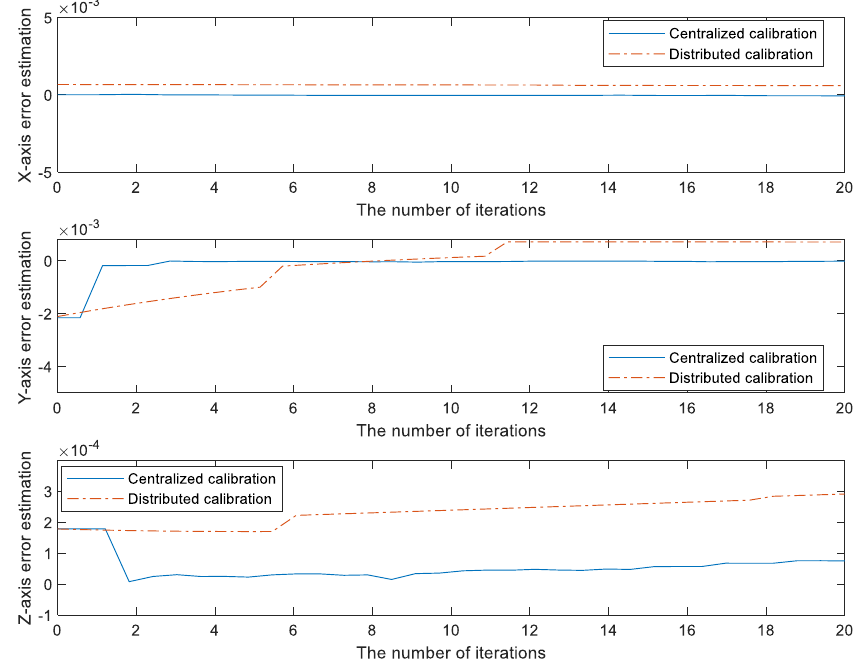
Figure 5. Accelerometer scale − factor − error estimation results.